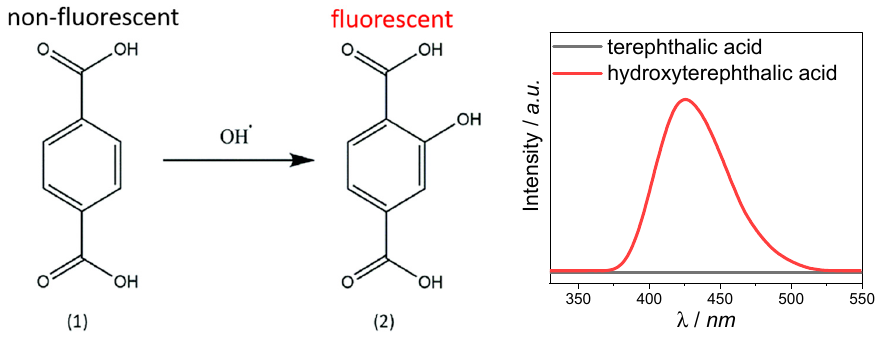
Scheme 1. Scheme of the terephthalic acid ( 1 ) reaction with hydroxyl radicals, resulting in generation of hydroxyterephthalic acid ( 2 ), which emits light at about 425 nm when excited with 315